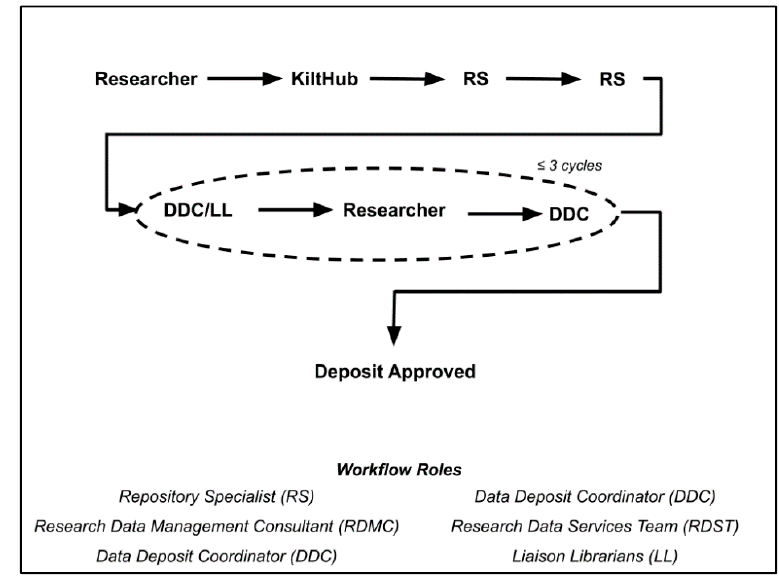
Figure 1. The KiltHub Repository Workflow. The steps in bold represent the minimally required steps within the workflow.